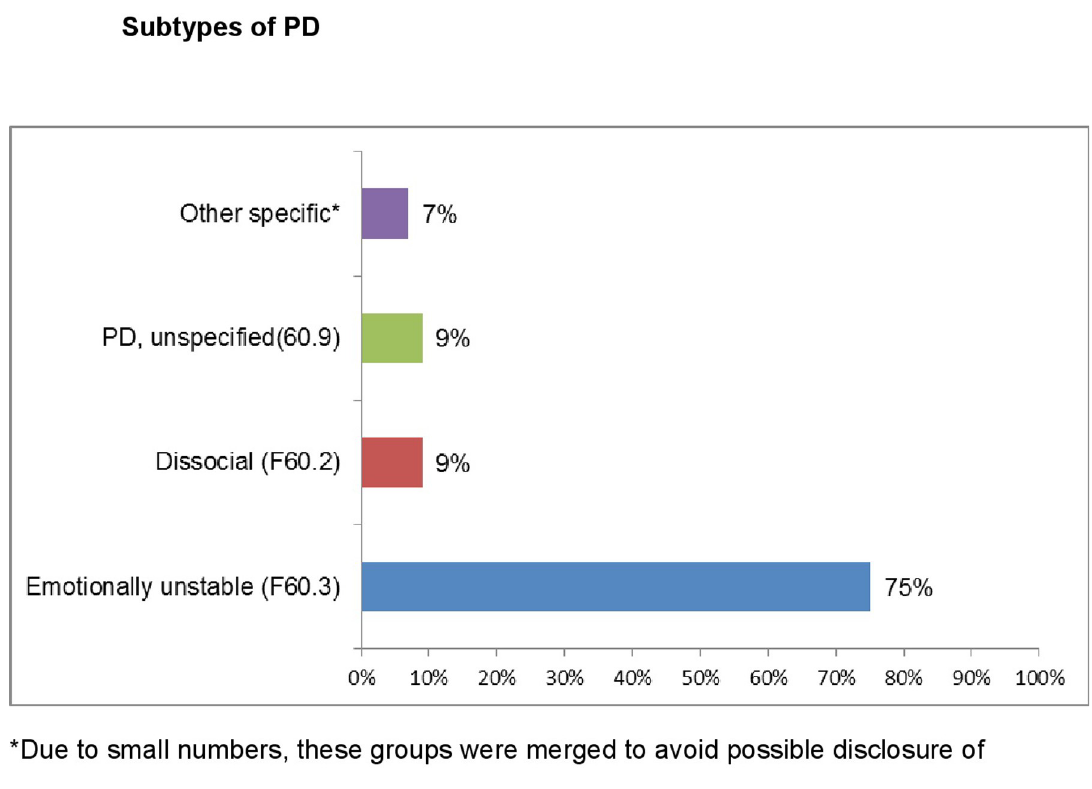
Fig 1. Sub-types of PD diagnosed (N = 76) among participants